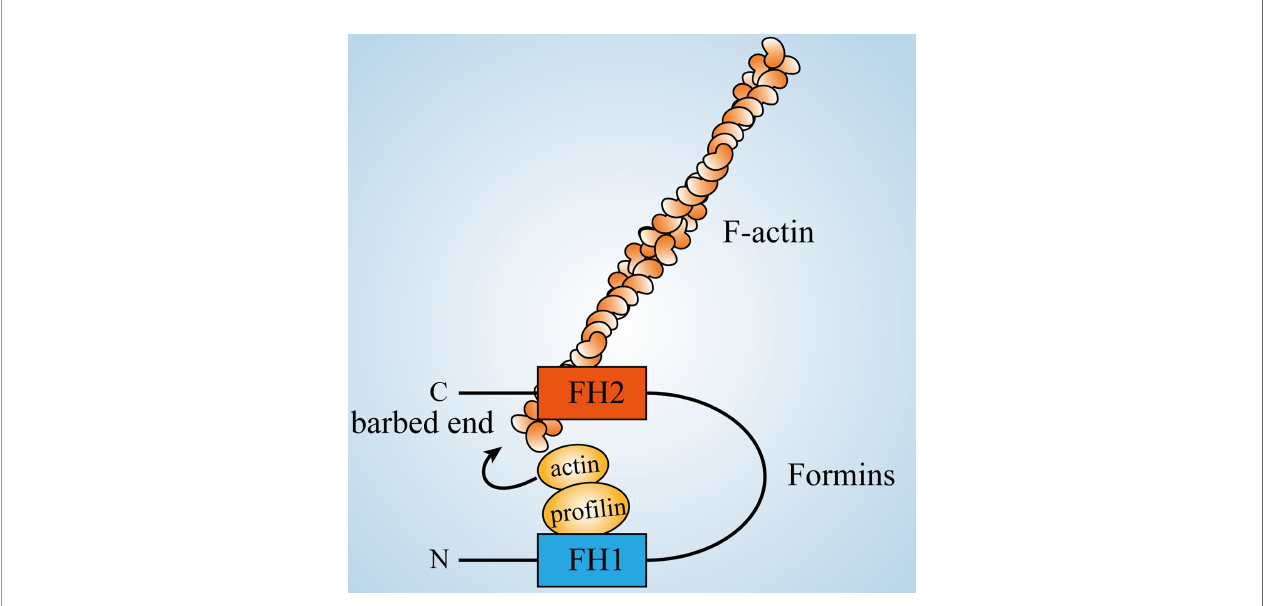
FIGURE 3 | Formins ’ role in regulating actin dynamics. The FH2 domain offormins close to the C-terminus can bind to the barbed end of fi laments, while the FH1 domain near the N-terminus can bind to pro fi lin-actin, thus increasing the concentration of actin monomers around fi laments and positively promoting their